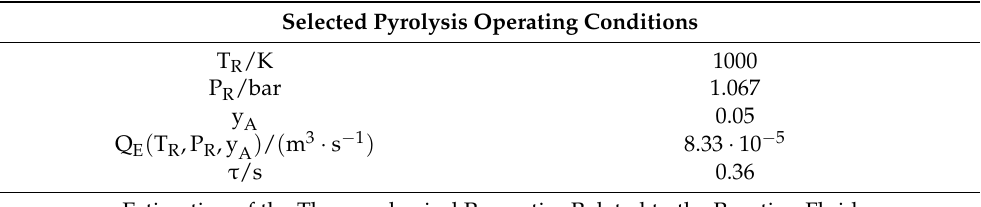
Table 2. Pyrolysis operating conditions selected for the reactor sizing (internal diameter d and length L) and the estimation of the thermophysical properties for the gas reacting fluid a